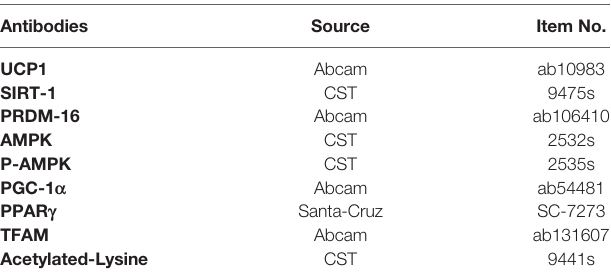
TABLE 1 | Antibodies. Antibodies Source Item